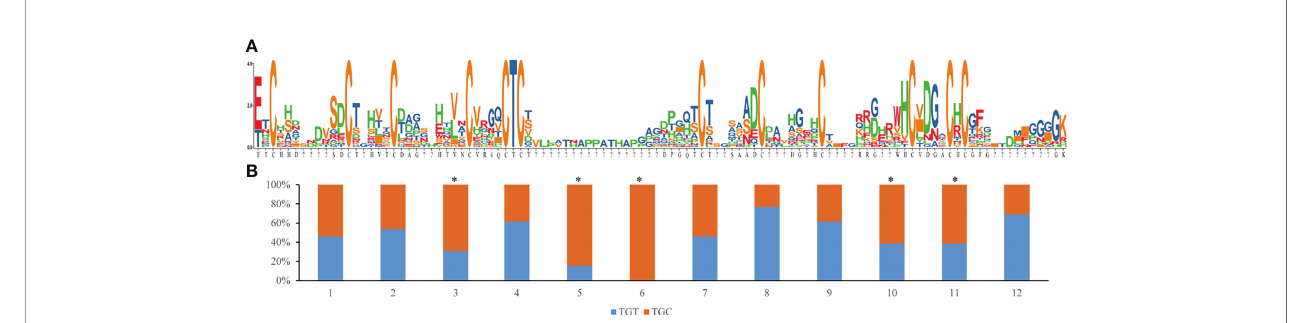
FIGURE 5 | Mature peptide sequence variability and conservation of cysteine residues, (A) Sequence logo of 13 mature peptide, the larger of the letter, the higher proportion of the amino acid in the position, ” ? ” means the position are not shared for all of the sequence; (B) Codon usage percentage of TGT or TGC for 12 conserved cysteine residues, the asterisk means that the ratio in that residue are deviated from the average of the whole genome codon usage frequency (0.646 for TGT and 0.354 for TGC).